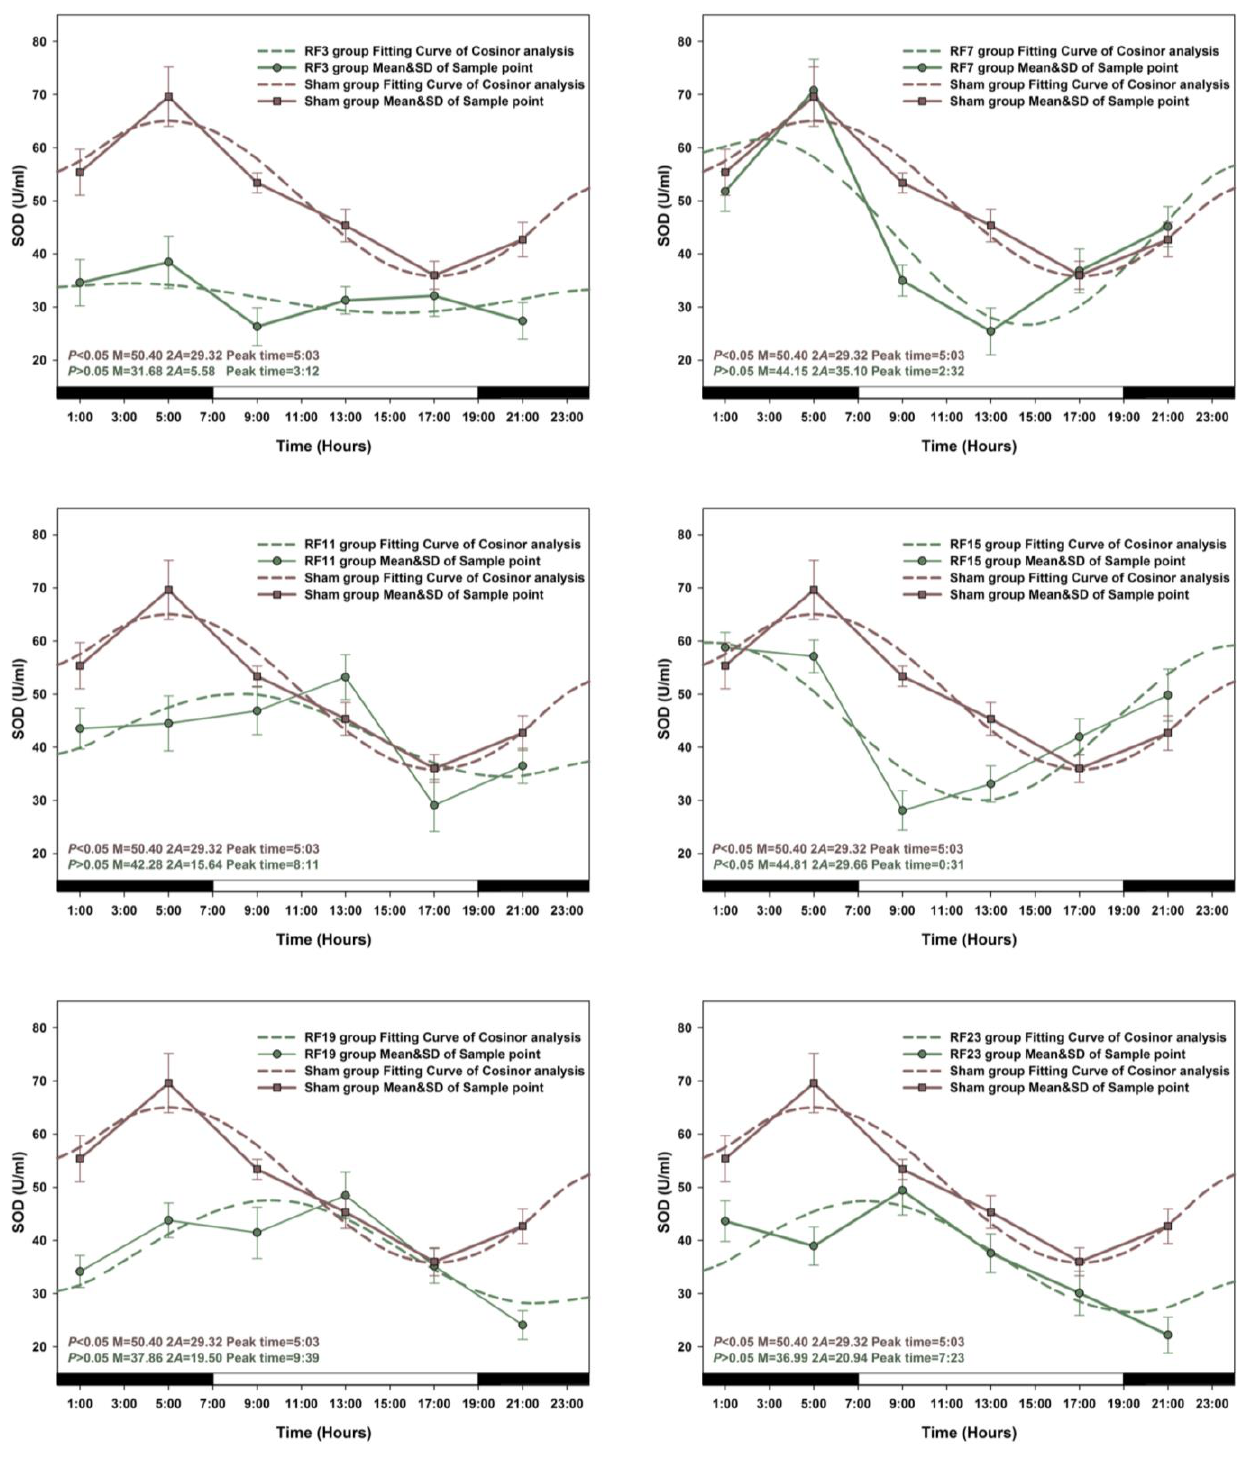
Figure 6. The best-fitting curves (means ± standard error) determined for SOD in RF and Sham-exposed rats. Y-axis represents SOD concentration in the plasma; x-axis represents the Time during the 24 h light-dark cycle. For time-effect, p values from Zero-amplitude test, as well as the median (M), the double amplitude (2A) and the time of peak phase (Peak time) of the 24 h cosine curves, are listed. The circadian rhythm is regarded as significant when p <